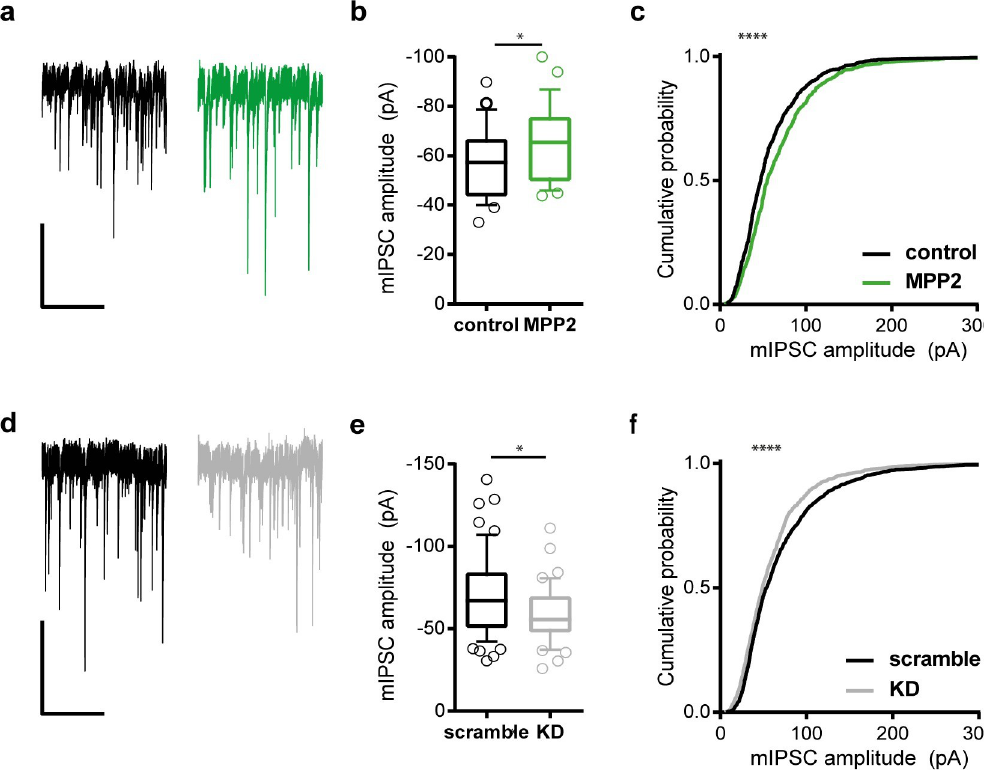
Fig 5. MPP2 expression levels influence mIPSC amplitudes. (a) Example traces of mIPSC in untreated (black) and MPP2-overexpressing (green) neurons. Scale bar: 100 pA/5s. (b) Overexpression of MPP2 leads to an increase in average mIPSC amplitude (unpaired t test p = 0.0403). Error bars of the boxplots correspond to the 10th and 90th percentile; control: n = 27; overexpression: n = 27. (c) Cumulative distribution of individual mIPSC amplitudes show a right-shift (larger amplitudes) in MPP2 overexpressing neurons. Kolmogorov–Smirnov test p < 0.0001. (d) Example traces of mIPSC from neurons transduced with control shRNA (black) and MPP2 knockdown shRNA (grey). Scale bar: 100 pA/5s. (e) Knockdown of MPP2 leads to a decrease in average mIPSC amplitude (Mann–Whitney test p = 0.0277). Error bars of the boxplots correspond to the 10th and 90th percentile; scramble: n = 58; KD: n = 40. (f) Cumulative distribution of individual mIPSC amplitudes shows a left-shift (smaller amplitudes) in MPP2 knockdown neurons (Kolmogorov–Smirnov test p < 0.0001). Underlying data can be found in S2 Data. mIPSC, miniature inhibitory postsynaptic current; MPP2, membrane protein palmitoylated 2.